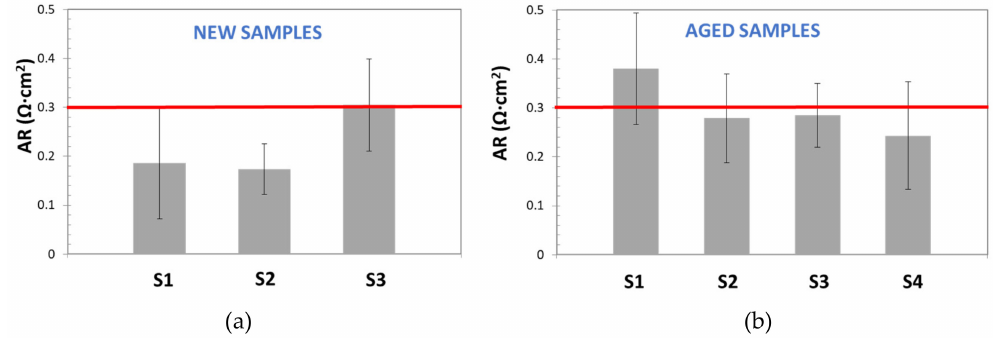
Figure 10. Area Resistance values, calculated for new ( a ) and aged ( b ) diaphragm samples. Each measurement was repeated 5 times (error bars are reported for each set of